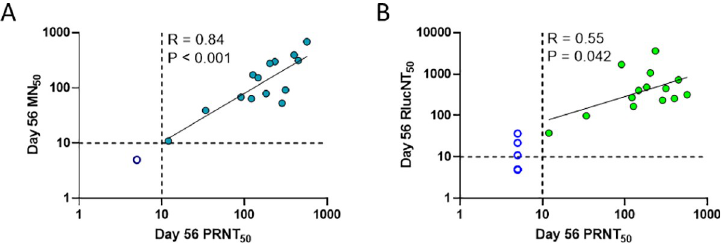
Fig 7. Correlation between serum neutralization titers determined by MN 50 or RlucNT 50 and PRNT 50 . (7A) Correlations were evaluated for MN 50 compared to PRNT 50 and for (7B) RlucNT 50 compared to PRNT 50 day 56 serum samples, with resultant R and P values shown and non-Log transformed values plotted. Closed circles depict individual monkey serum samples that had detectable titers for both assays and that were included in the regression analysis, while open circles depict sera that were negative for at least one assay and excluded from analysis. R and P values and regression lines shown by least squares regression. Dashed lines show assay detection limits. Any titers below the limit of detection were assigned a value of 5 for graphing and visualization